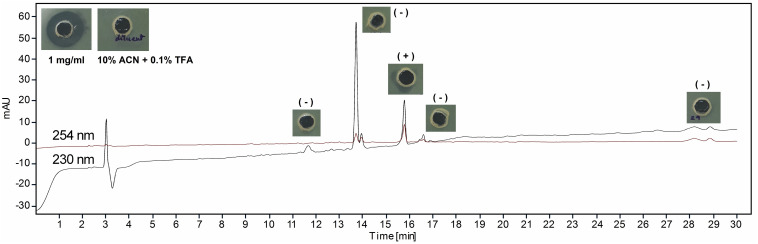
High-performance liquid chromatography (HPLC) analysis of lantibiotic. The insets are the antimicrobial activity of collected peaks, control (10% acetonitrile containing 0.1% trifluoroacetic acid, v/v), and test (1 mg/ml) lantibiotic against Micrococcus luteus MTCC 106T. Data are representative of three independent replicates.